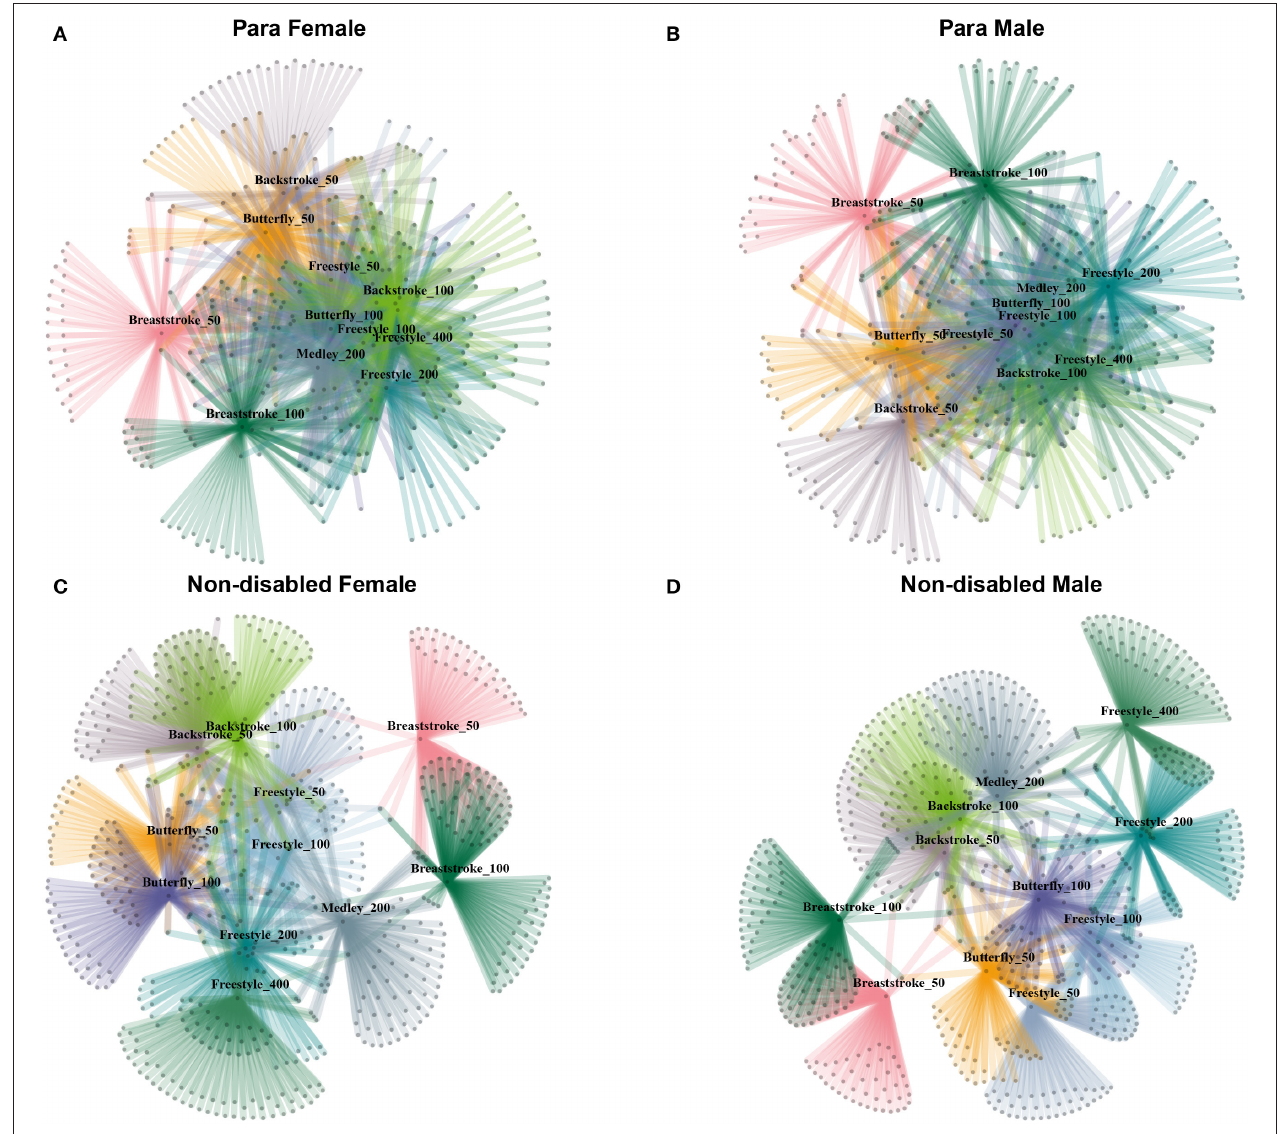
FIGURE 2 | Bipartite network representation of the involvement in multiple events for Para female (A) , Para male (B) , non-disabled female (C) , and non-disabled male (D) . Labeled nodes represent types of event (stroke and distance); non-labeled ones represent